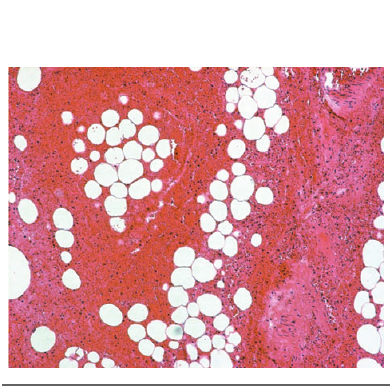
Figure 2. Histology of the strangulated omentum showing subtotal haemorrhagic necrosis/infarction (H&E stain; original magnification X200).